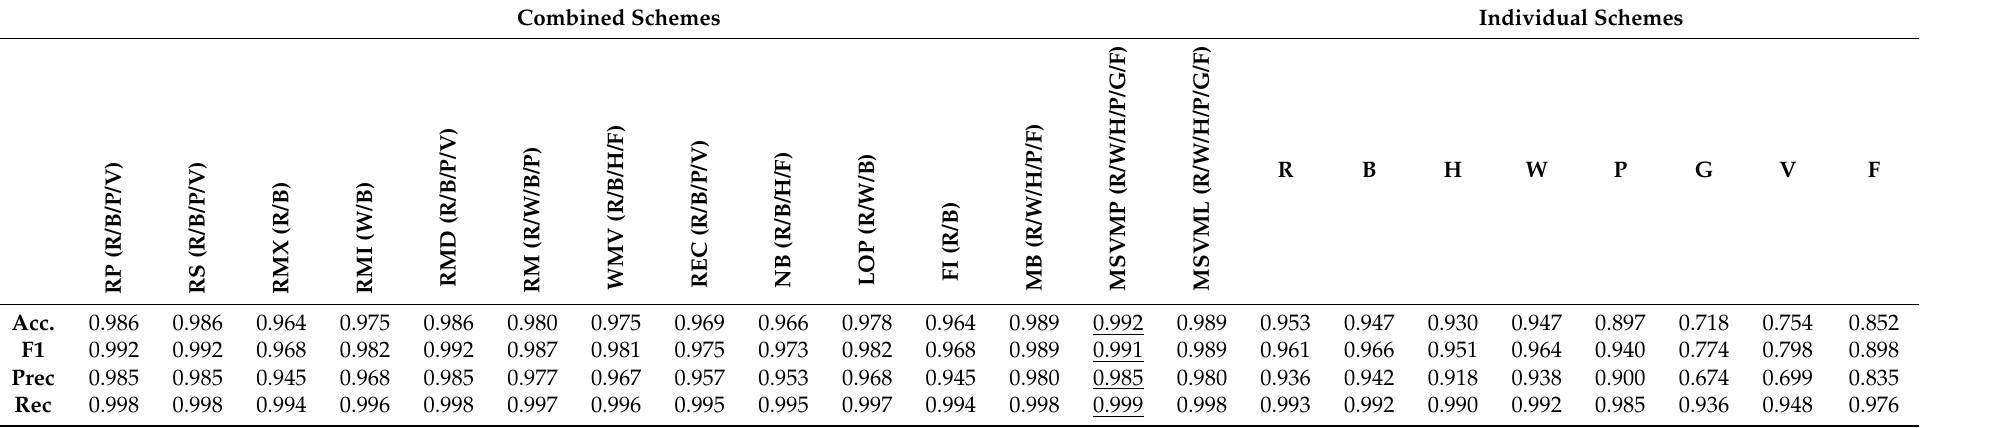
Table 6. The best schemes for each combination rule ( e · 1000 − 1 ) for the CK+ data set. Acc: accuracy; Prec: precision; Rec: recall. Best classifier result is underlined.